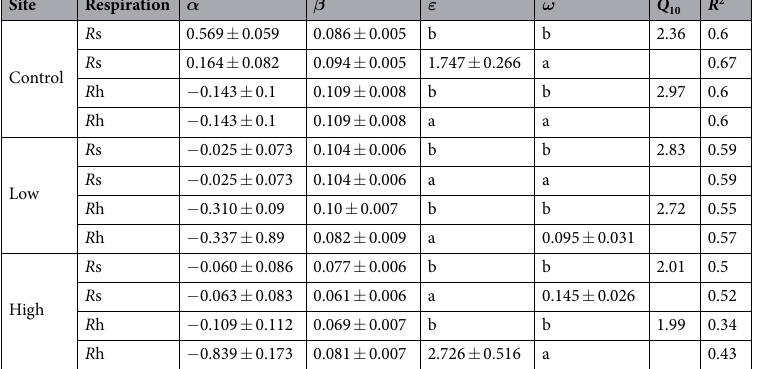
Table 1. Summary of the regression models of soil respiration against soil temperature ( L n( R s) = α + β × T ) and the best-fit regression models of soil respiration against soil temperature and soil moisture ( L n( R s) = α + β × T + ε × W + ω × T × W ), where T is the soil temperature (°C), W is the soil moisture (%), and T × W is the interaction effect of T and W . Note a that this variable of the model was not significant in an ANOVA (at the P = 0.05 level), b and this variable was not included in the model.